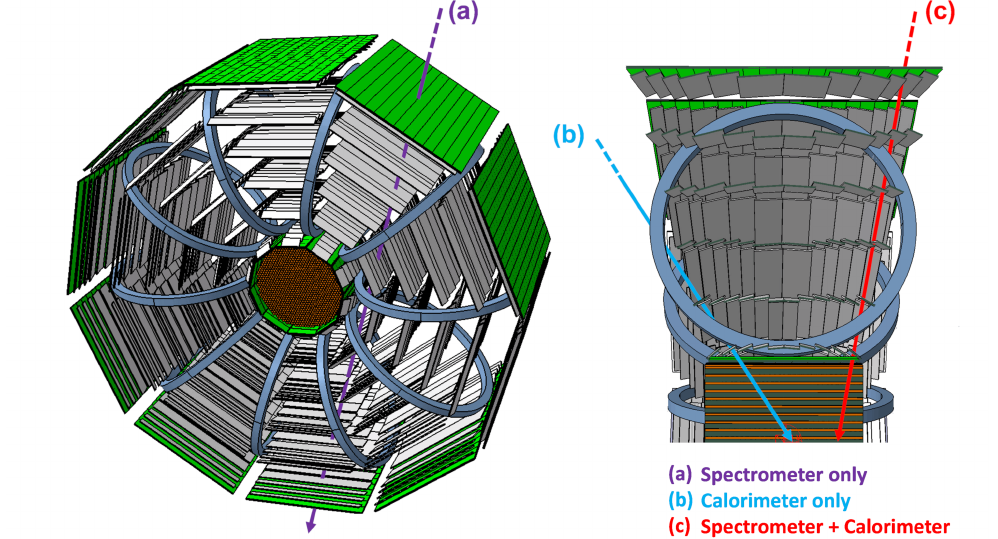
Figure 3. Graphical illustration of the main acceptance configurations of the ALADInO detector for high-energy particles (straight tracks). ( a ) Particle crossing the spectrometer only; ( b ) particle crossing the calorimeter only; ( c ) particle crossing the spectrometer and the calorimeter. Figure readapted from[96] under license CC BY